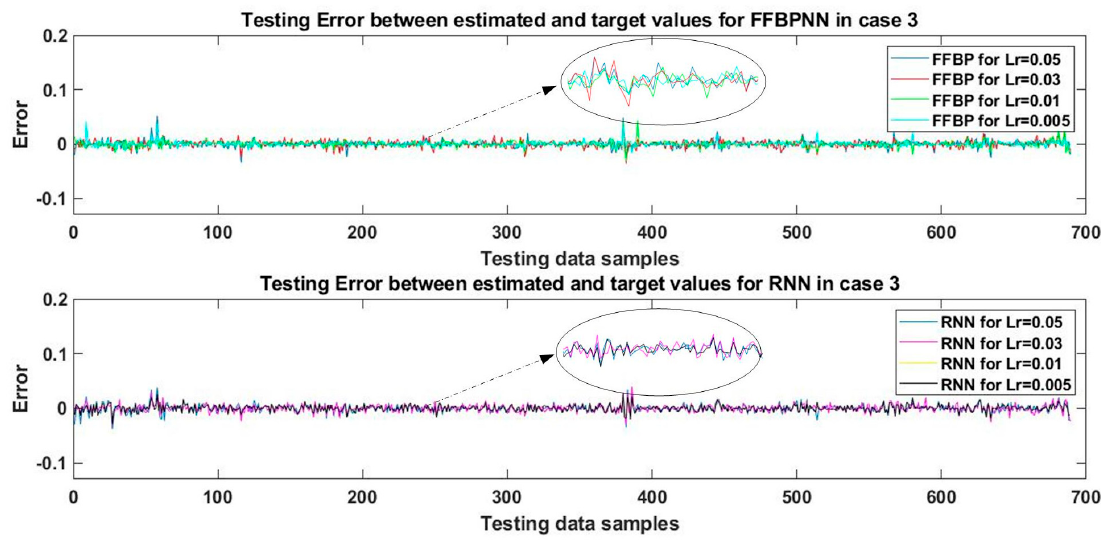
Figure 6. Testing error between estimated and target values for case 3.